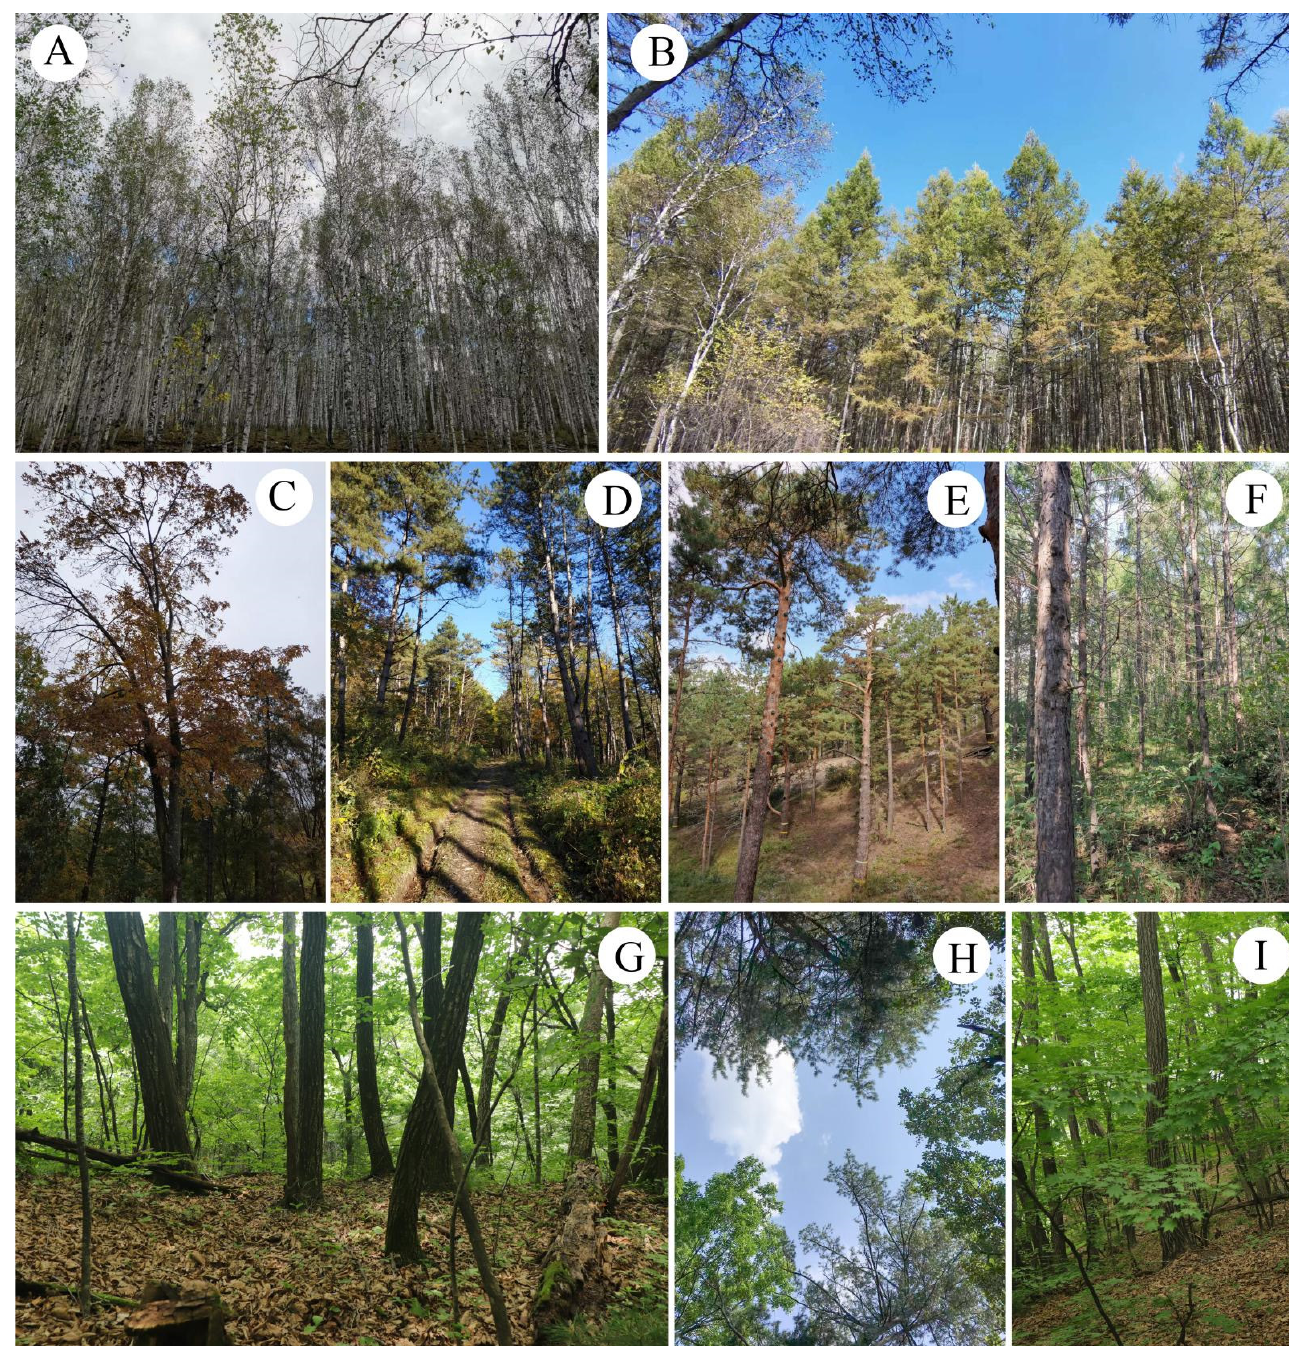
Figure 2. Forest types from the investigation sites in Jilin Province. ( A ) Betula platyphylla forest; ( B ) Cunninghamia forest; ( C ) broadleaf mixed forest (mainly Acer sp.); ( D – F ) Pine forest; ( G ) Quercus mongolica forest; ( H ) Coniferous and broadleaf mixed forest ( Pinus and broadleaf mixed forest); ( I ) Quercus mongolica forest.